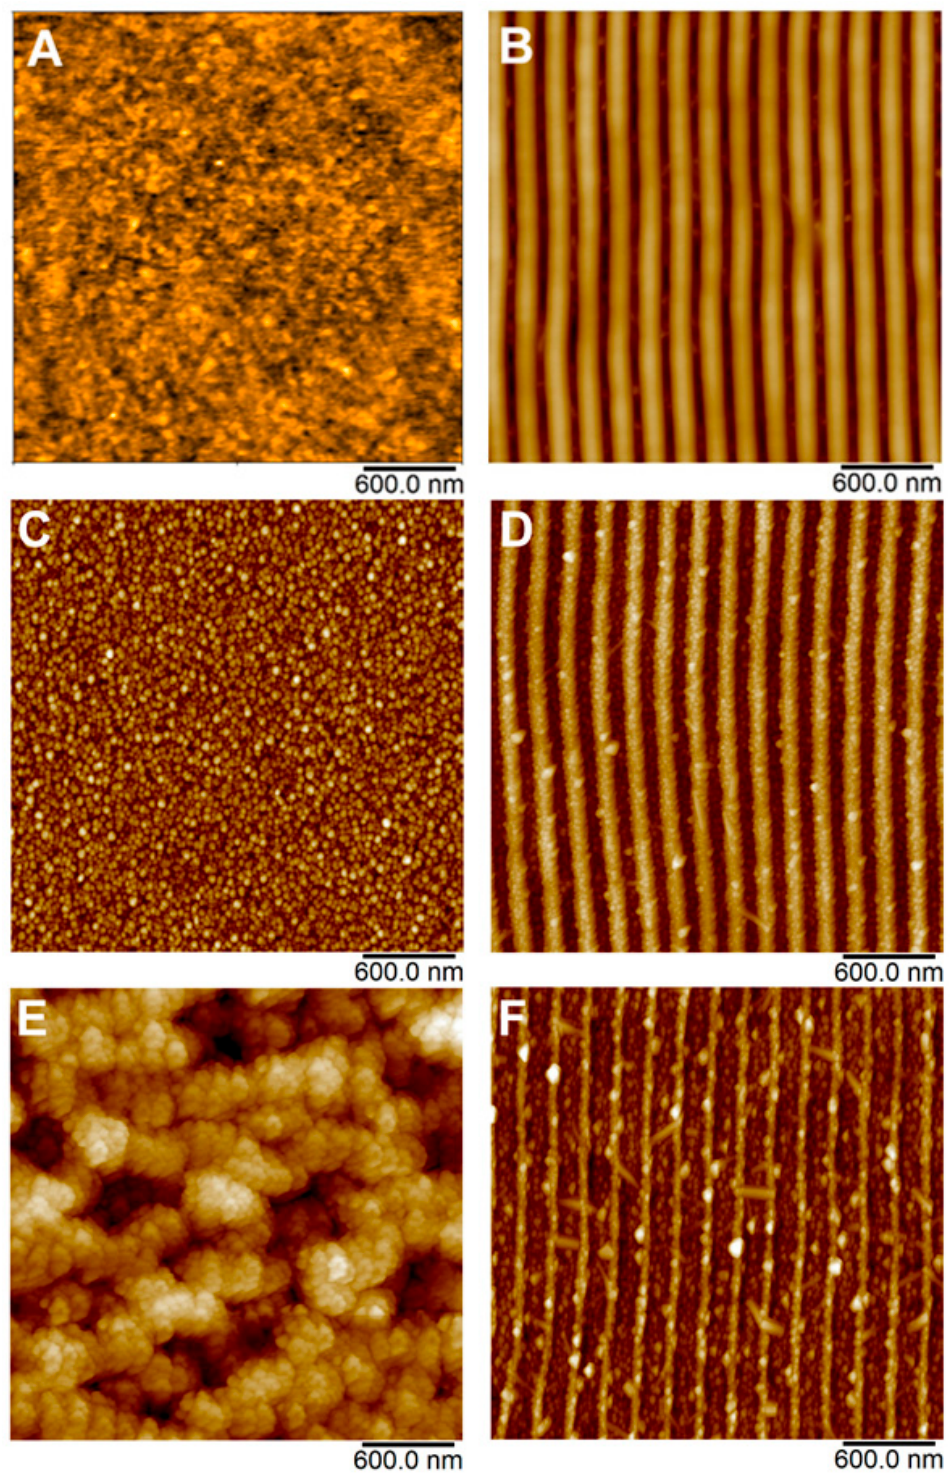
Figure 2. AFM images of pristine PET ( A ); laser pre-treated PET with LIPSS structure ( B ); and PET with immobilized AgNPs on pristine PET ( C , E ) and PET with LIPSS structure ( D , F ).